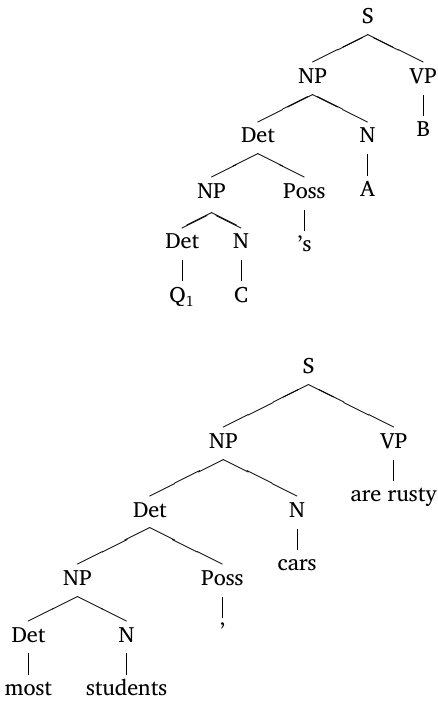
Case with implicit predeterminer